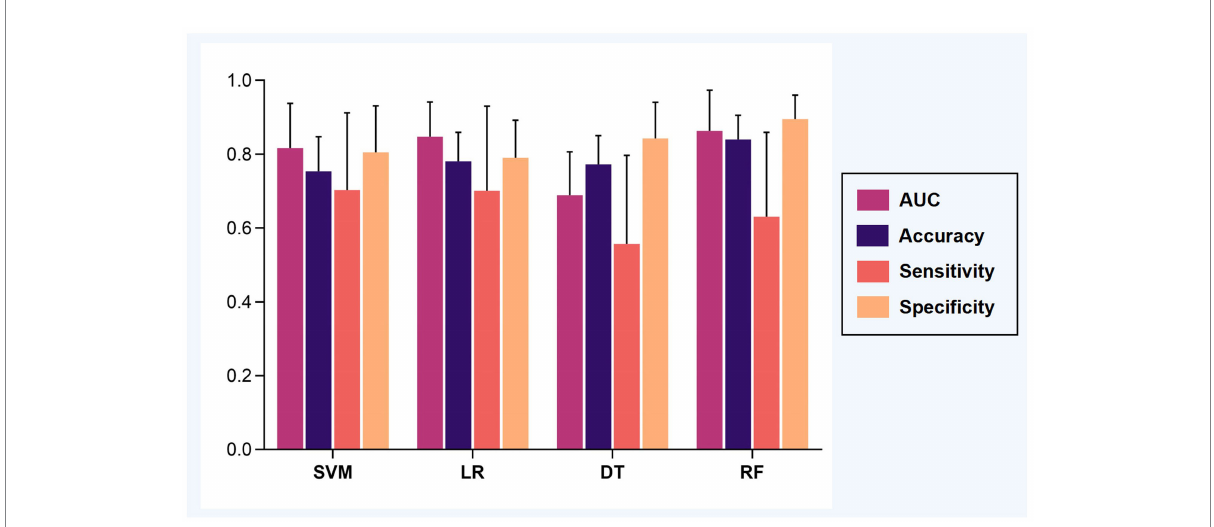
FIGURE 3 The classification performance of models. The mean AUC, accuracy, sensitivity, and specificity were calculated based on 100 runs of repeated re-divided dataset randomly. Abbreviations: AUC, an area under the curve; SVM, support vector machine; LR, logistic regression; DT, decision tree; RF, random forest.